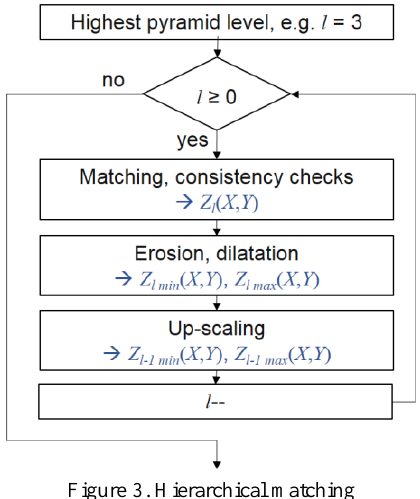
Figure 3. Hierarchical matching The initial matching is performed in the highest level (low resolution) of the pyramid without any limitation of the search range. Afterwards, the matching result is analysed by deriving minimum and maximum Z-values by applying erosion and Figure 2. Paths of minimum costs dilatation operators on the index map Z l ( X , Y ) for the current pyramid level l . For both, erosion and dilatation, windows with a fixed size of 7x7 elements are used for each pyramid level. Larger windows sizes extend the search ranges in case of high variations in Z-direction (e.g. in urban areas).